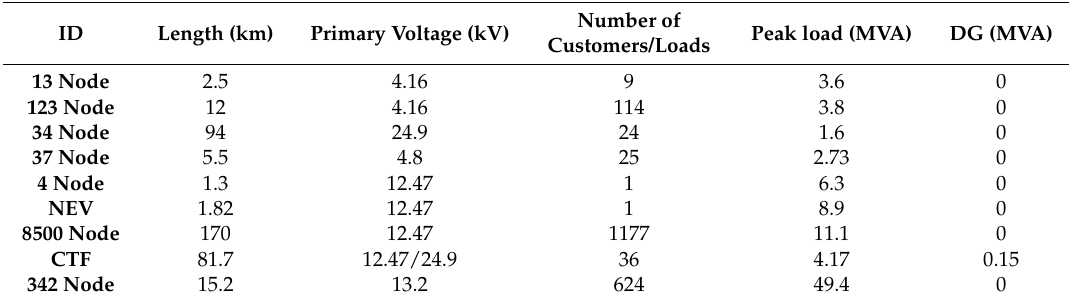
Table 1. Institute of Electrical and Electronics Engineers (IEEE) Test Feeders